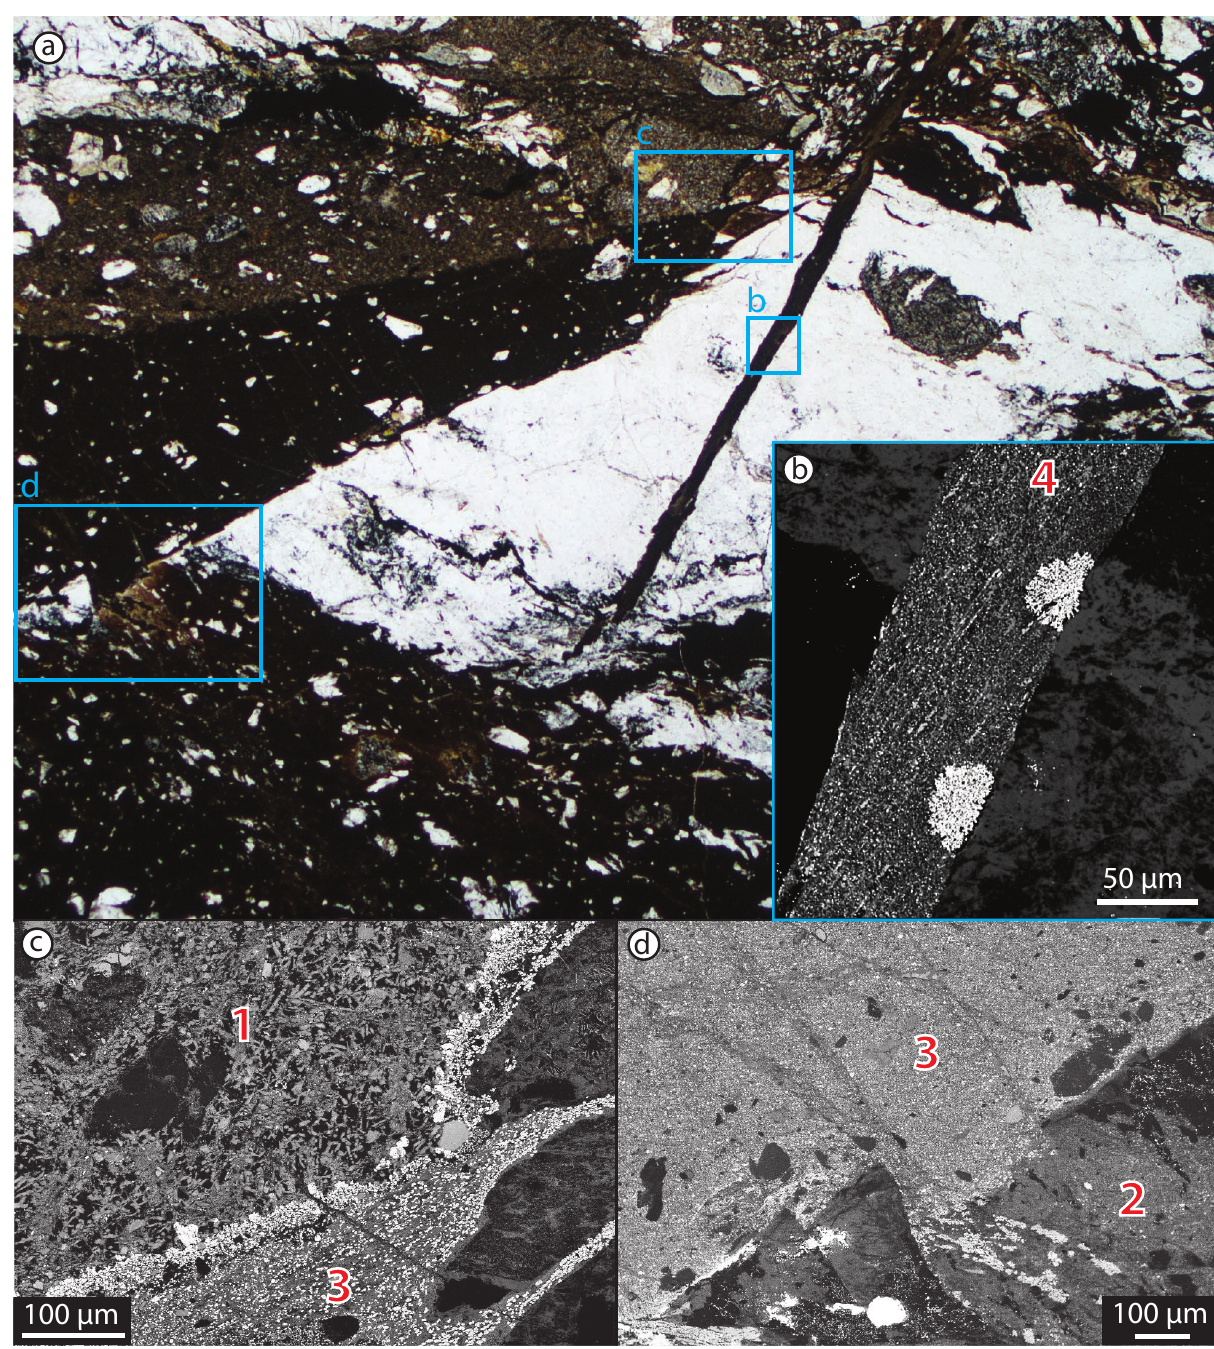
Figure 4. (a) Thin section image of sample F44 (26.4514S, 131.9553E) showing four generations of pseudotachylyte, from the oldest (1) to the youngest (4) (plane polarized light; to reduce contrast, images taken with different exposure times were combined). (b) Backscattered electron image of the area indicated by the blue box in (a) : a vein of generation 4 shows a planar foliation, defined by elongate clasts, that is oblique to the vein boundary and is overgrown by dendritic (or “cauliflower”) garnet. (c) Pseudotachylyte generations 1 and 3 showing a former chilled margin now decorated by garnet. (d) Pseudotachylyte generation 3 cross-cutting generation 2, with the boundary offset by late